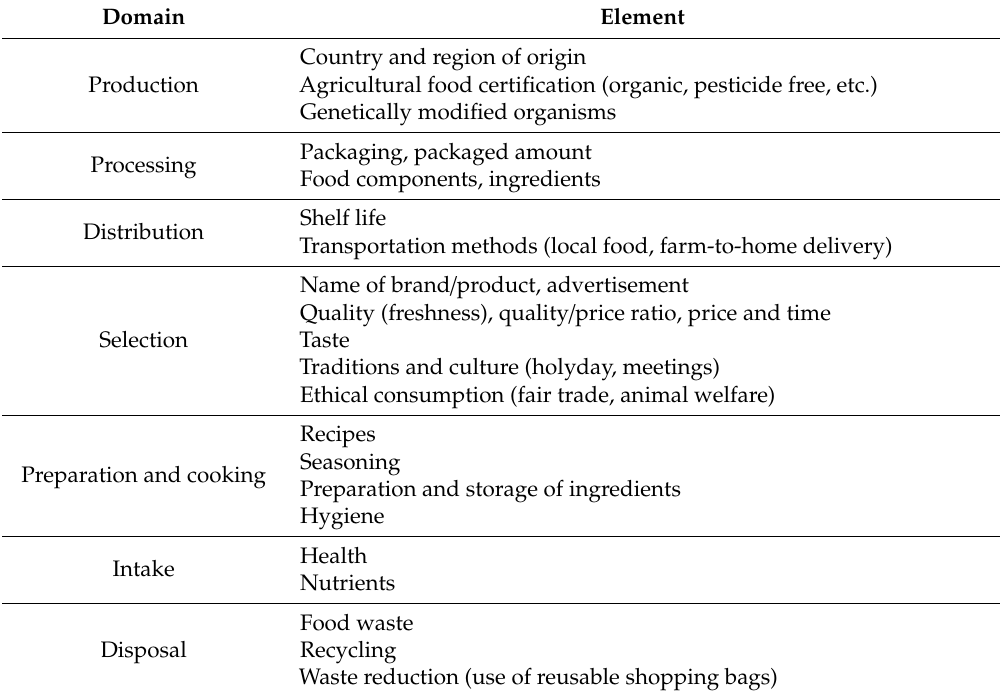
Table 3. Categorization of food literacy components of the food system dimension derived from focus group